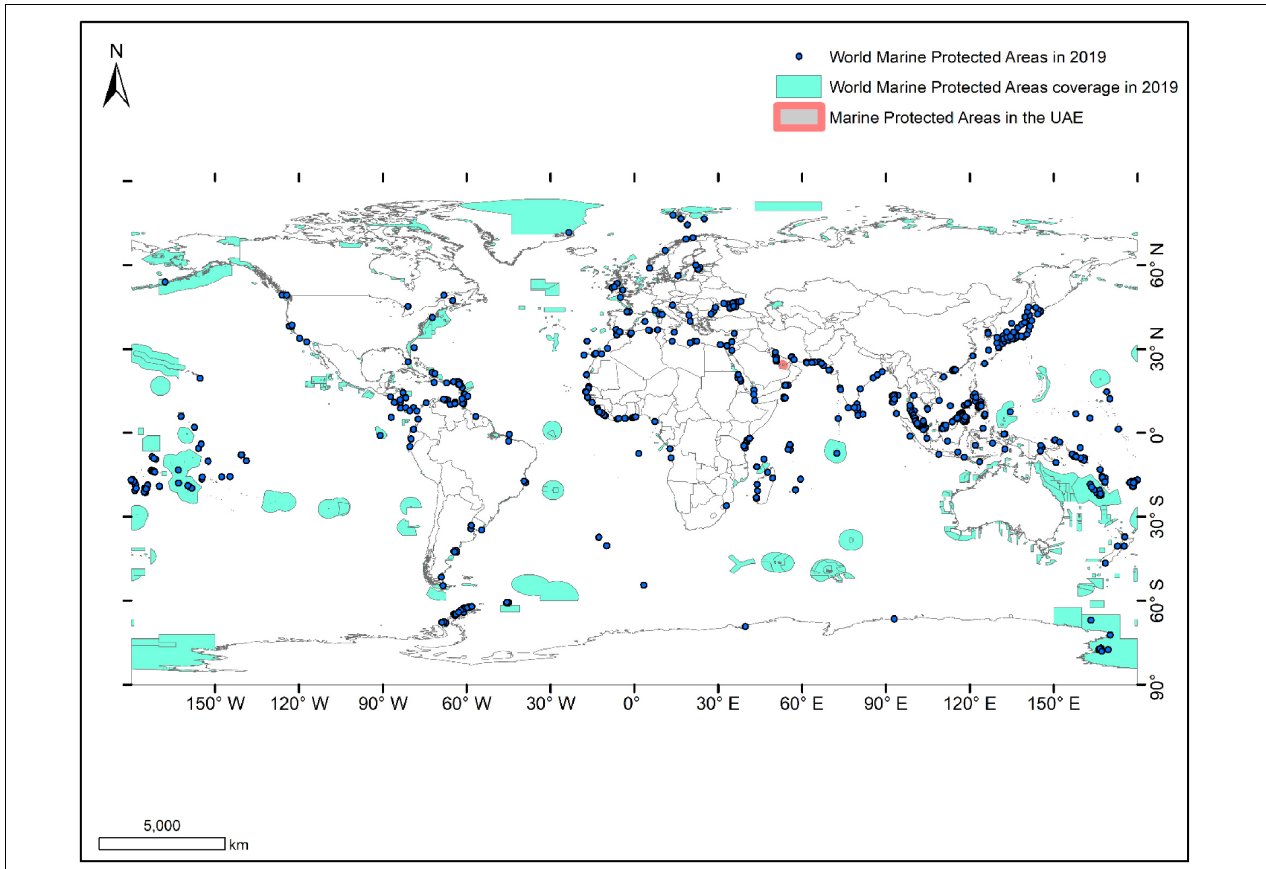
FIGURE 1 | The global coverage of marine protected areas in 2019. GIS data credit: UNEP-WCMC and IUCN (2019). Protected Planet: The World Database on Protected Areas (WDPA) [On-Line], May 2019, Cambridge, United Kingdom: UNEP-WCMC. GIS data are available at www.protectedplanet.net. In 2000, the area covered by MPAs was approximately 2 million km 2 (or 0.7% of the Ocean), since then there has been over a 10-fold increase in MPA coverage with 23 million km 2 (or 7.59%) of the ocean being covered by MPAs (UNEP-WCMC and IUCN, 2019).